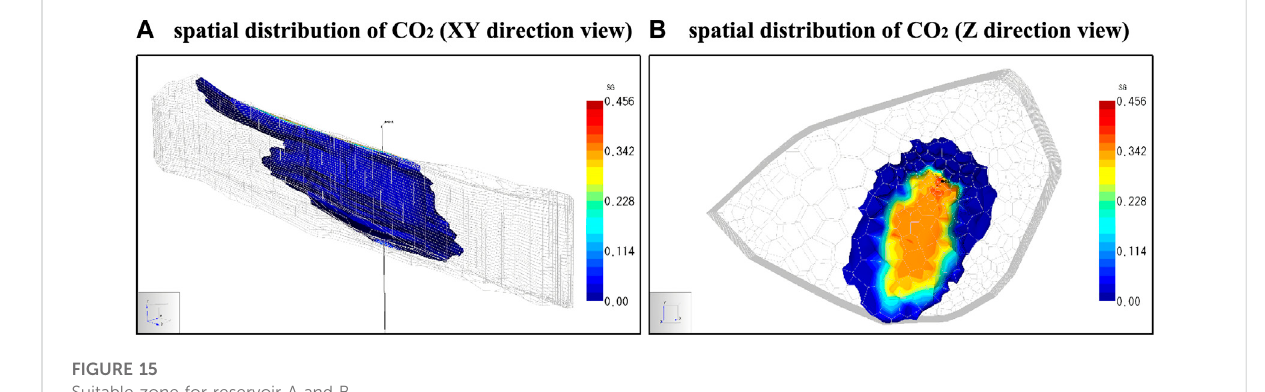
FIGURE 15 Suitable zone for reservoir A and B.